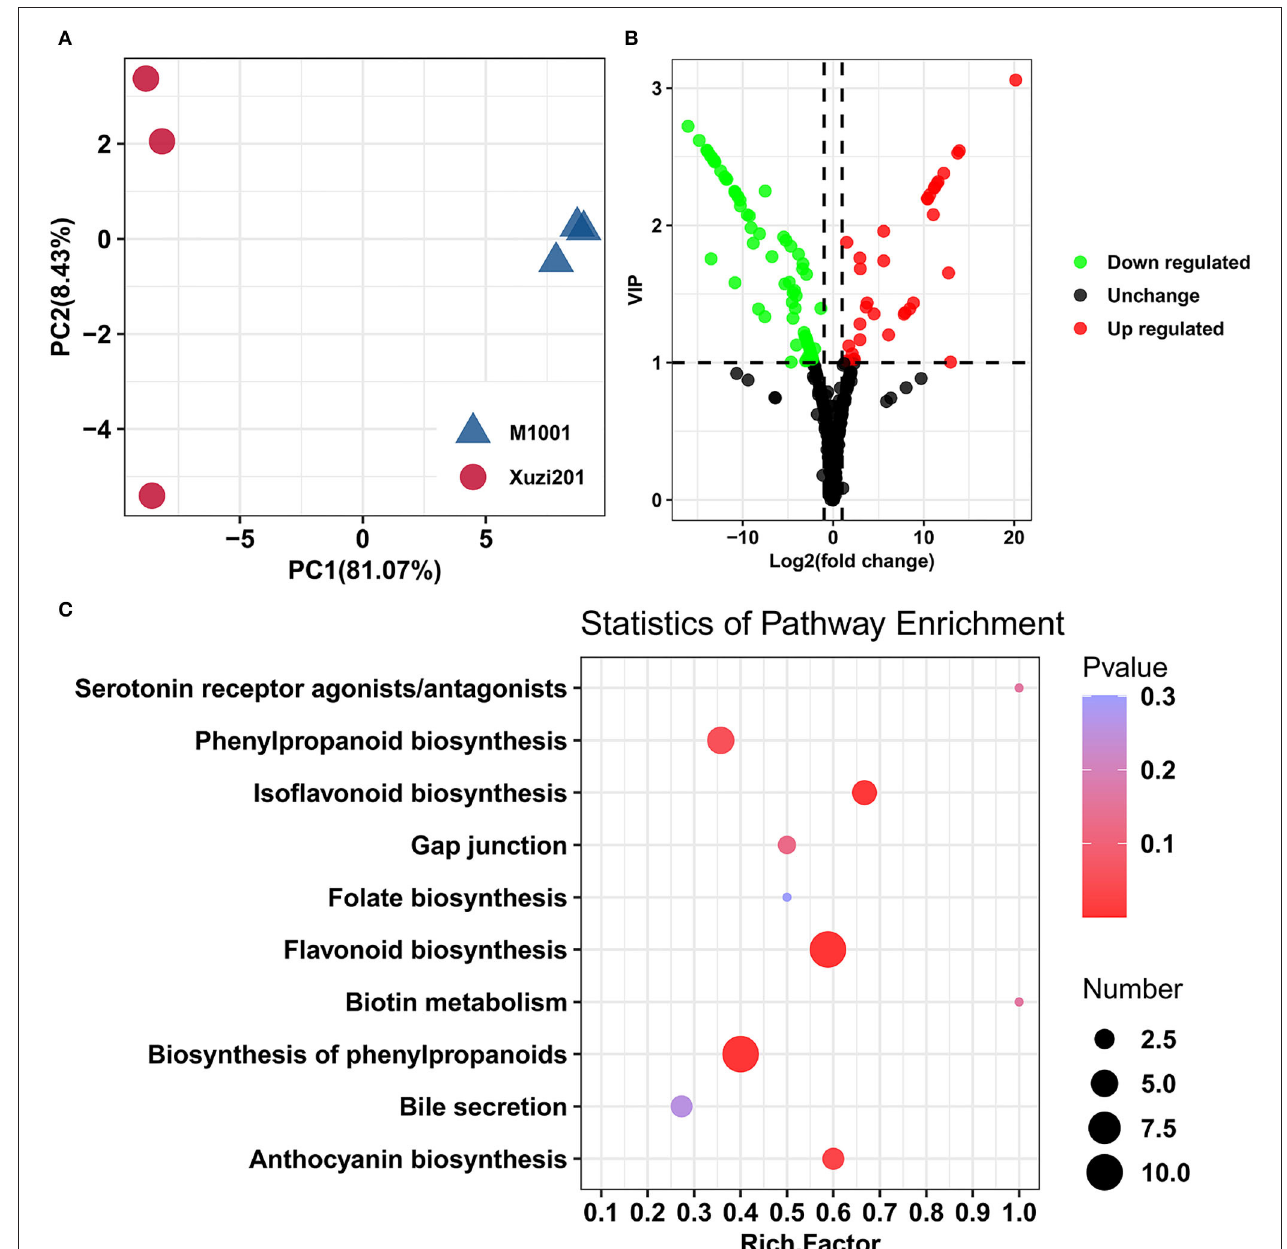
FIGURE 2 | Metabolome analyses of tuberous roots of Xuzi201 and M1001. (A) PCA analyses of metabolites identified in Xuzi201 and M1001. X-axis represents the first principal component. Y-axis represents the second principal component. (B) Volcano plots displaying the upregulated, downregulated, and no regulated metabolites between Xuzi201 and M1001. Horizontal coordinates are Log 2 FC of metabolites, and vertical coordinates are variable important in projection (VIP) values of metabolites. The red, green, and black dots represent upregulated, downregulated, and unchanged metabolites. (C) Top ten KEGG enrichment terms of differentially expressed metabolites. The horizontal coordinate indicates the rich factor of each pathway, the vertical coordinate is the name of the pathway, and the color of the dot is the P -value; the redder it is, the more significant the enrichment. The size of the dots represents the number of differential metabolites